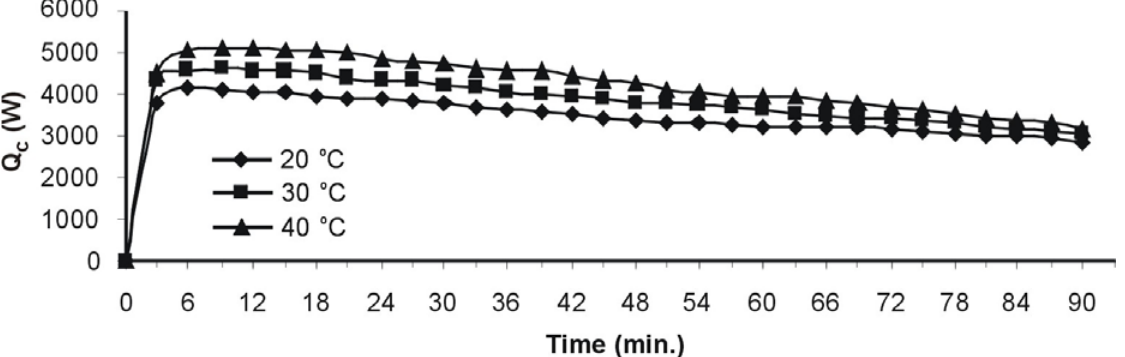
Figure 8. The change in the heat amount discarded from the condenser along the experiment for the circulation pump flow rate CP